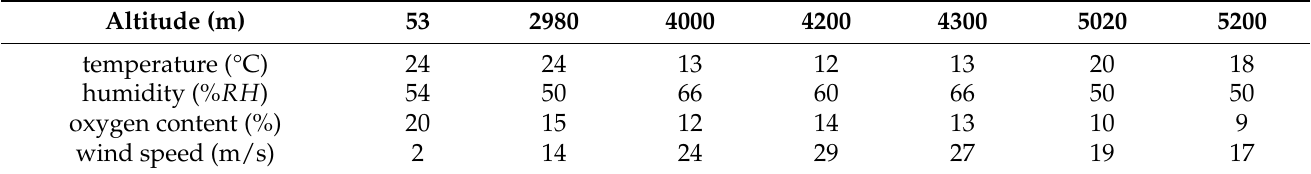
Table 2. The environmental information at different altitudes.